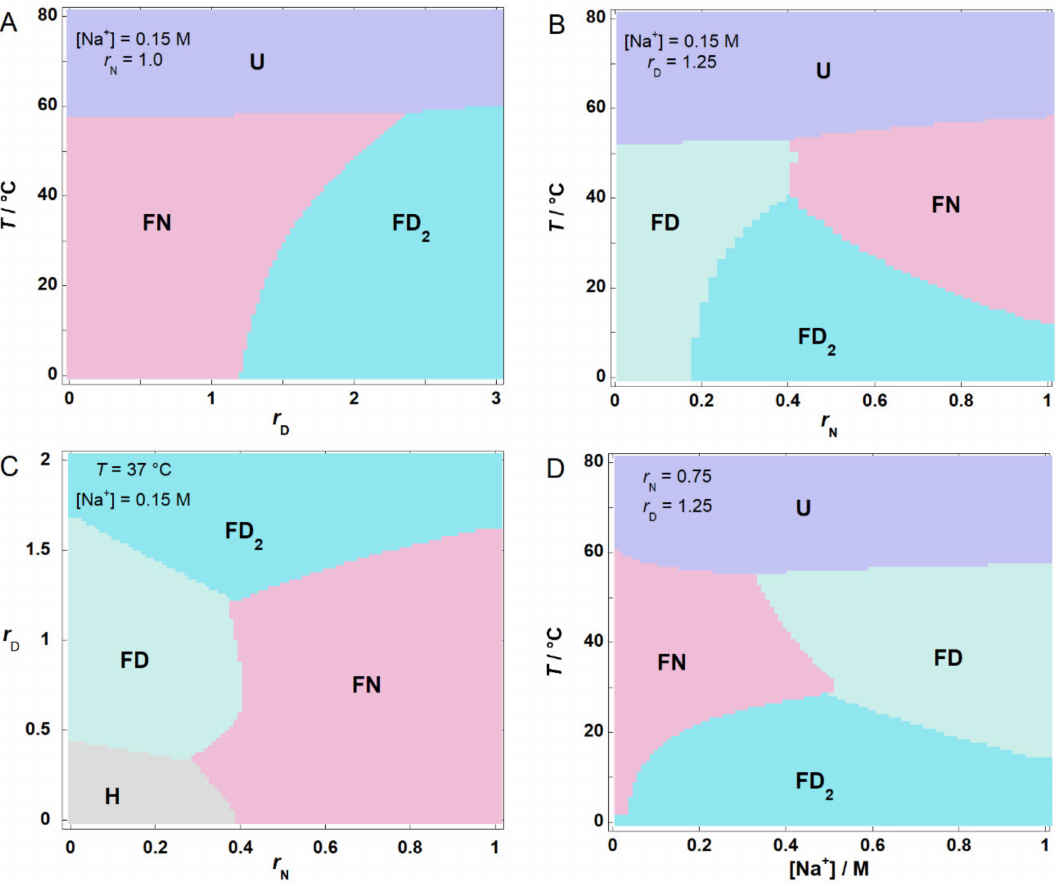
Figure 2. Phase diagrams showing the most populated model predicted DNA species (Scheme 1) at C DNA = 5 µ M. T versus given r D diagram (panel A ), T versus r N diagram (panel B ), r D versus r N diagram (panel C ), and T versus [Na + ] diagram (panel D